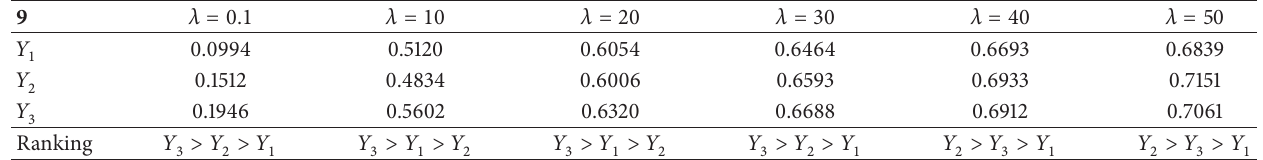
Table 9: Score values obtained by the GIVIHFWA and GIVIHFHA operators and the rankings of alternatives.